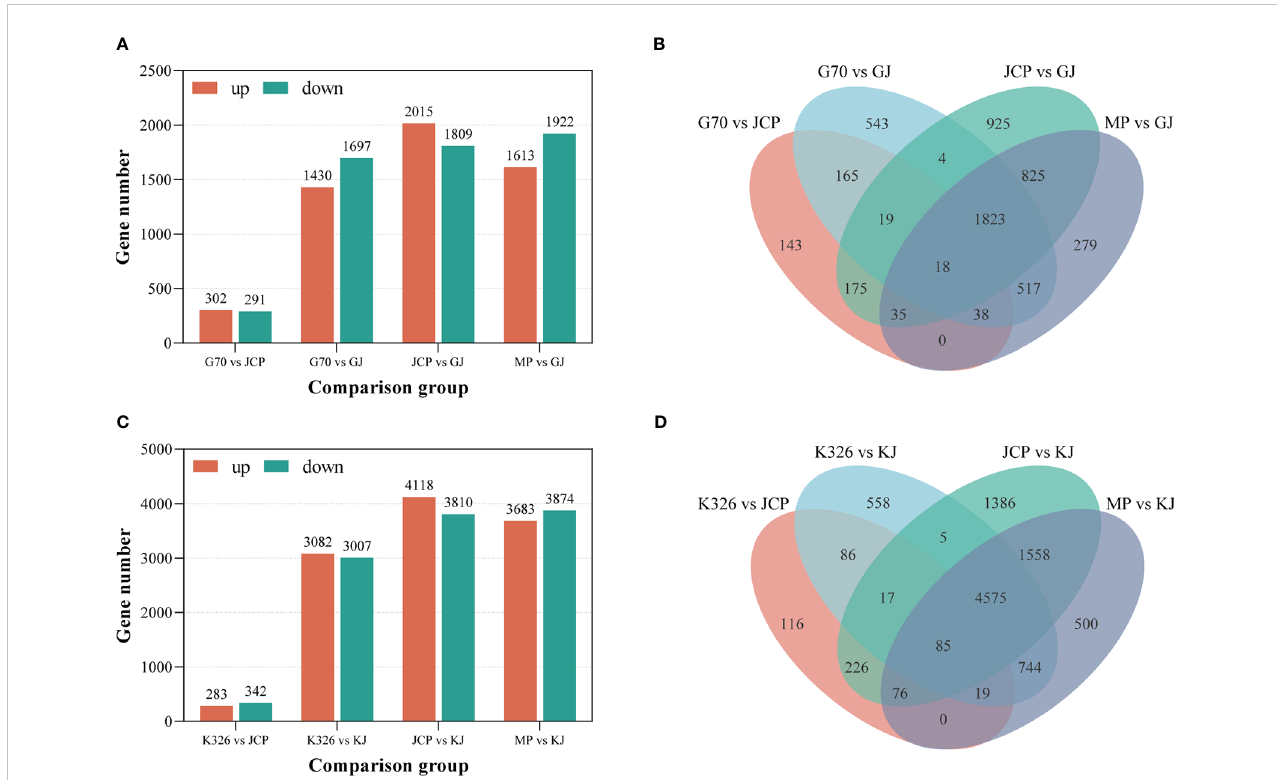
FIGURE 3 Distribution of differentially expressed genes (DEGs) between hybrids and parents. MP represents the average value of parents. (A) The number of different expressed genes between GJ and its parents during root development. (B) Venn shows the distribution of GJ and parental DEGs. (C) The number of different expressed genes between KJ and its parents during root development. (D) Venn shows the distribution of KJ and parental